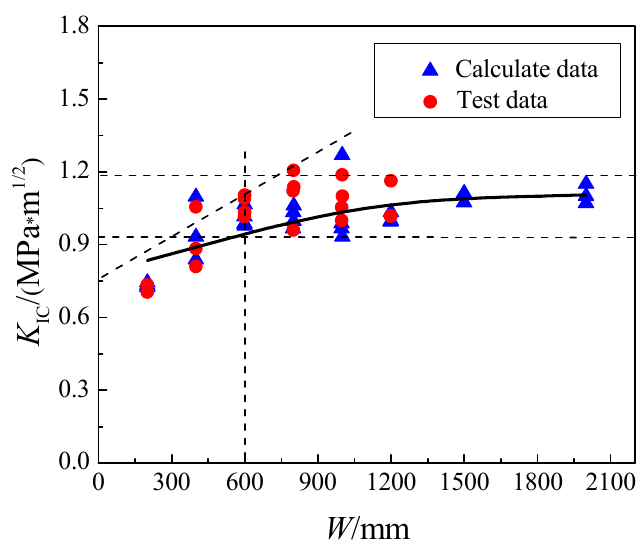
Figure 7. E ff ects of specimen height on fracture toughness K IC Figure 7. Effects of specimen height on fracture toughness K IC.